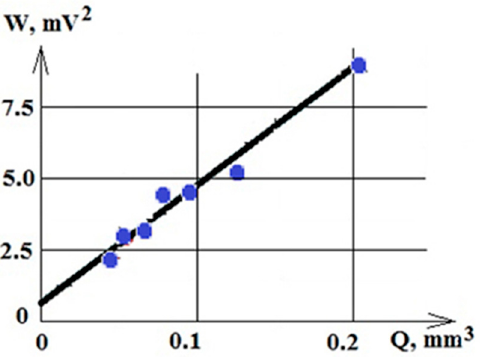
Figure 18. Dependence of the oscillation energy on the amount of valuable work.